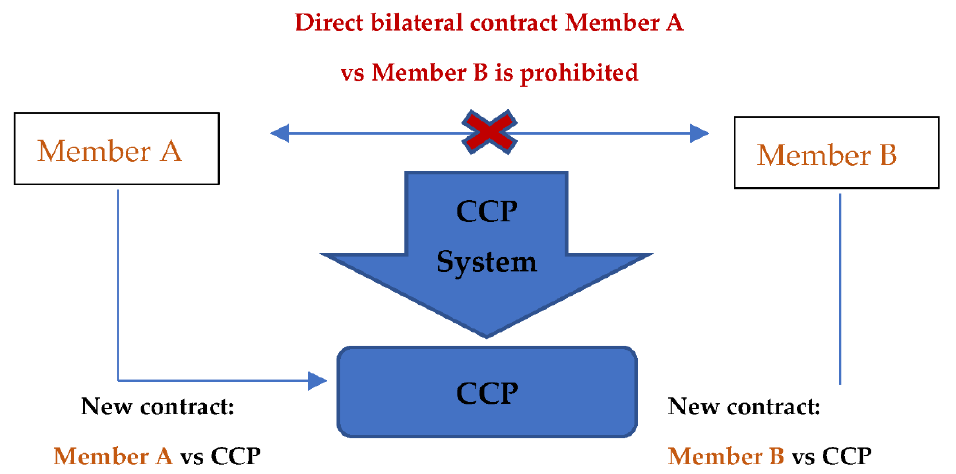
Figure 3. Over-the-counter (OTC) transaction with CCP system. Source: Regulation of Bank Indonesia on the implementation of Central Counterparty for Derivative transactions on Interest rate and currency at the Over the Counter, 2019.